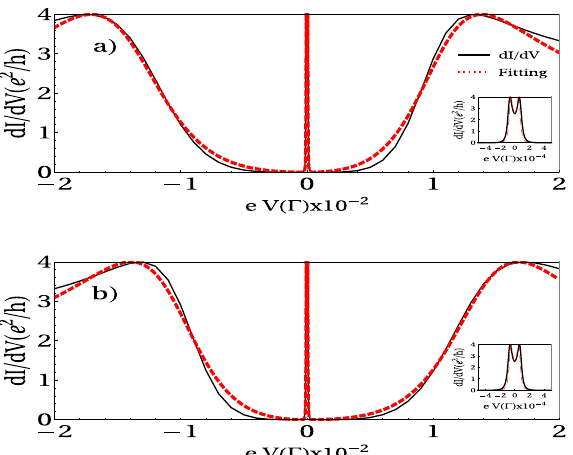
Figure 8. ( a ) The differential conductance (black line) as a function of the bias voltage of a TQD system and 2 . ( b ) Differential 0.000075 Ŵ r the fitting (red line) by the sum of the Fano and BW functions when ǫ d = = conductance (solid line) calculated as a function of the bias voltage of a TQD system and the proposed fitting 2 . The zoom of both figures shows the differential conductance 1.000075 Ŵ and r (dashed line) when ǫ d = = − 1 Ŵ , t 0.1 Ŵ , and the fitting proposed by the function BW in the low energy limit. Fixed parameters: U = = 0.001 Ŵ η =